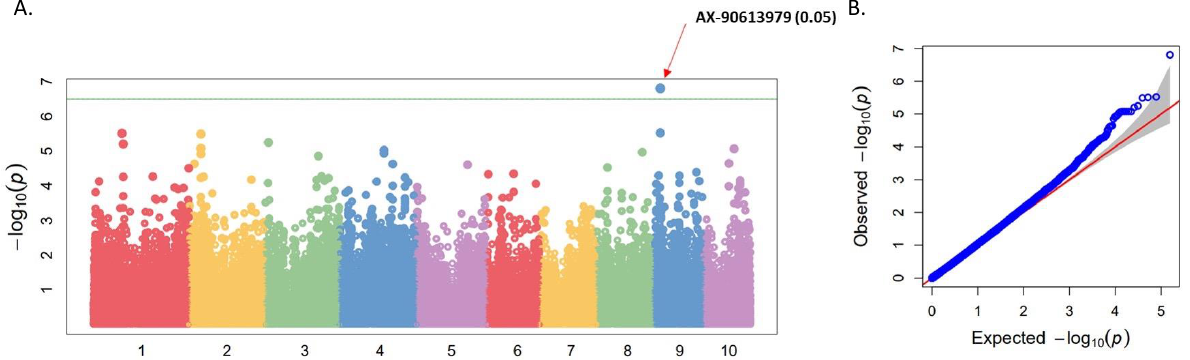
Figure 3. GWAS results for the trait waxy/normal kernel in 213 maize inbred and recombinant inbred lines genotyped with 155,768 SNPs using an MLM model implemented in GAPIT. ( A ) Manhattan plots. Each dot represents one SNP. The numbers on the horizontal axis represent maize chromosome number. The Bonferroni threshold of − log10(P) = 6.49 is represented by a green line on the Manhattan plots. The most associated SNP (AX-90613979) is indicated by a red arrow. ( B ) Quantile–quantile (Q–Q) plots. The plot shows the expected versus observed − log10(P) of each marker (blue dots). The red line is a benchmark for perfect fit to the expected − log10(P). The gray shaded area shows the 95% confidence interval for the Q–Q plot under the null hypothesis of no association between the SNP and the trait. Table 1. QTL and significant SNPs identified by GWAS. SNP ID, chromosome, positions, − log10(P) values, minor allele frequency (MAF) values, and candidate gene are provided.